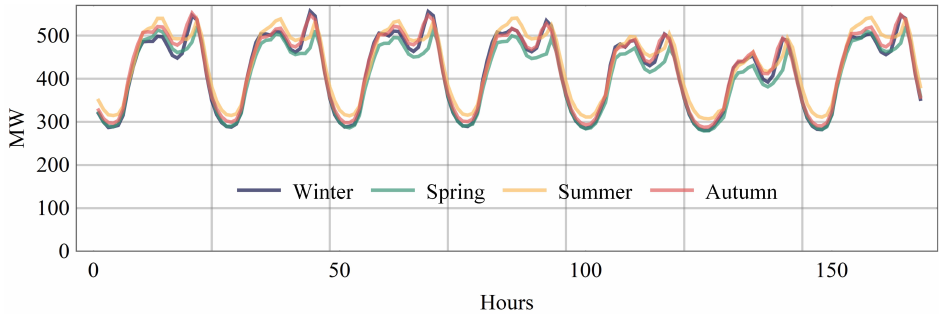
Figure 4. Estimated demand of 2026 for a sample week of winter, spring, summer, and autumn.